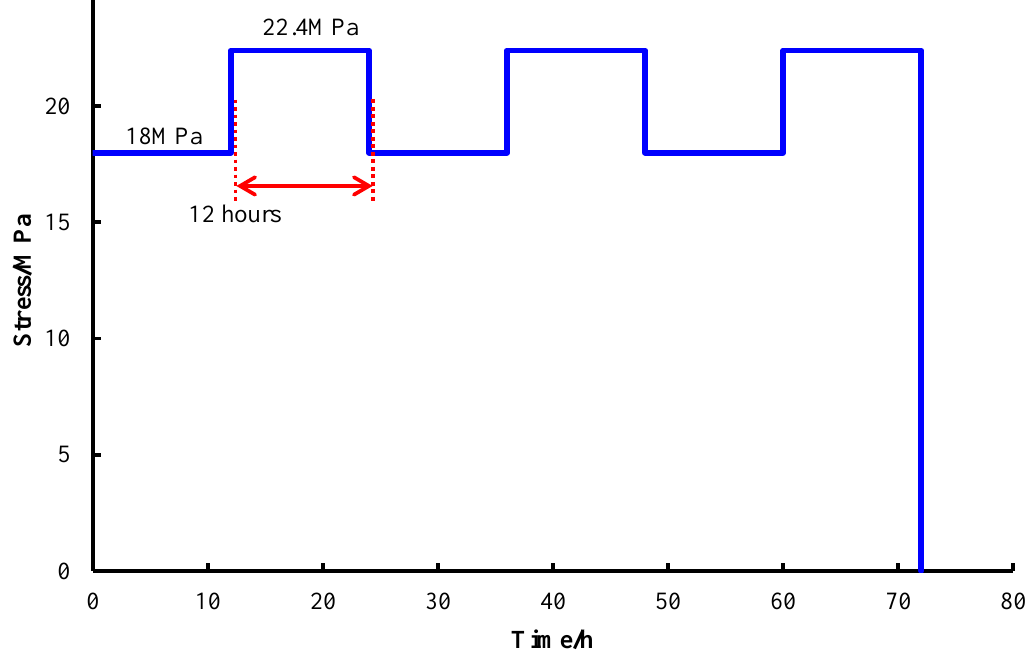
Figure 5. Schematic of the multi-step creep tests. The stress level of every stage was maintained for 12 h. After three high-stress and low-stress loading stages, the applied stress was reduced to zero.